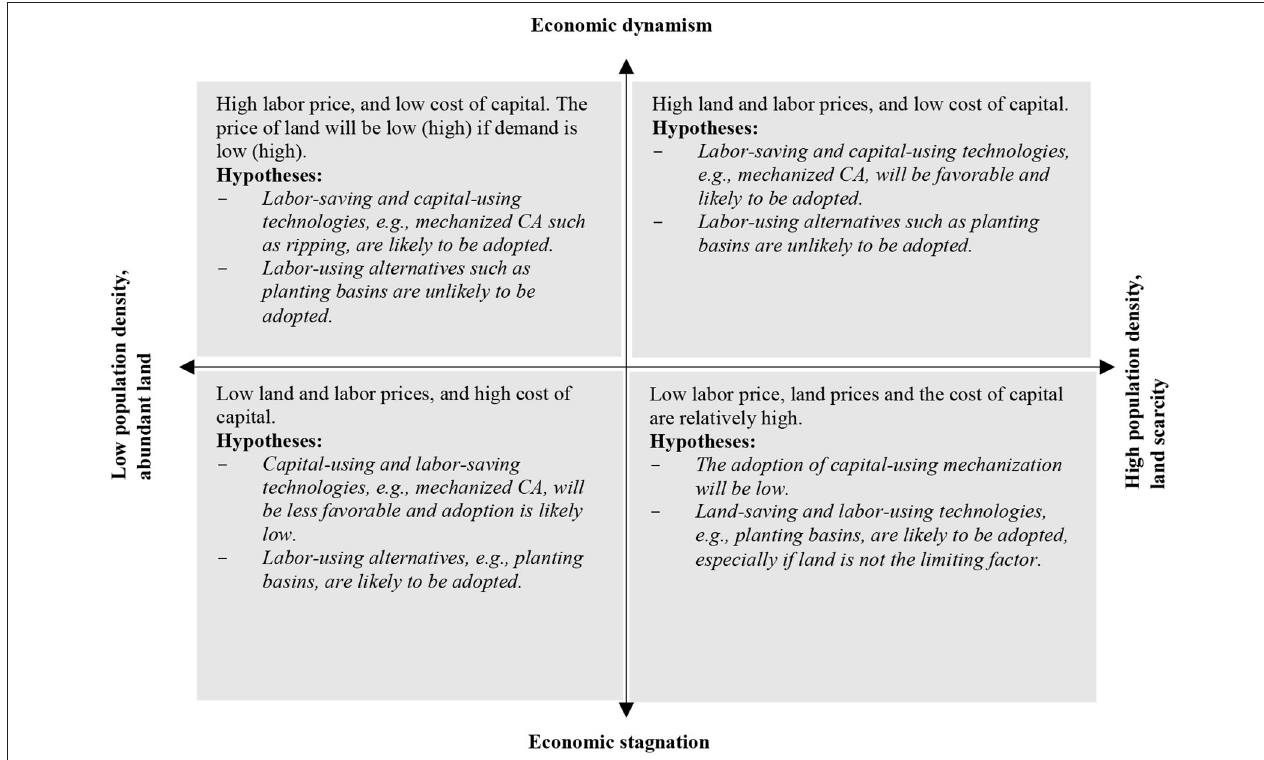
FIGURE 1 | Expected adoption of different elements of conservation agriculture as determined by population density and economic dynamism.